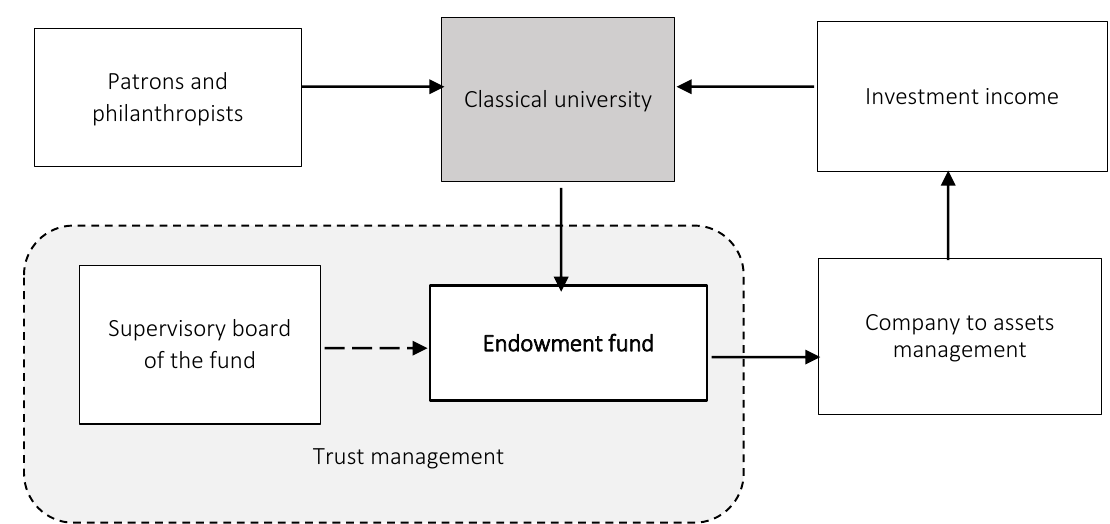
Figure 1. Cash flow in the endowment fund of a classical